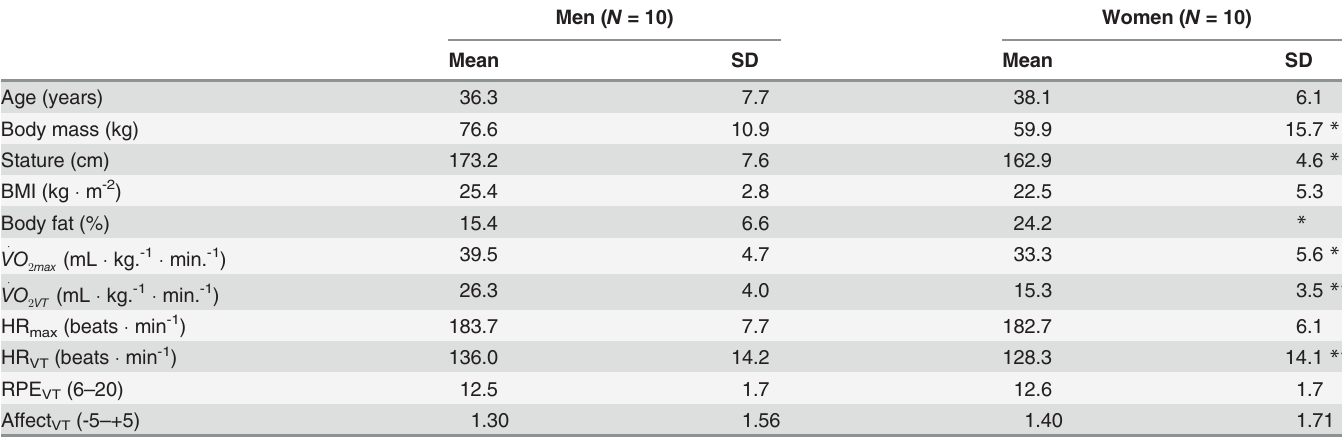
Table 1. Anthropometric characteristics and physiological, exertional, and affective responses to maximal graded exercise test of the